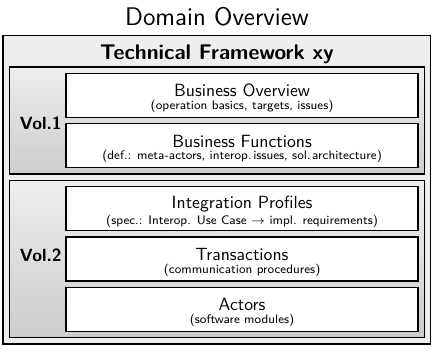
Figure 7. The Document structure of Technical Frameworks: a top-down approach from Use Cases definition to Integration Profiles